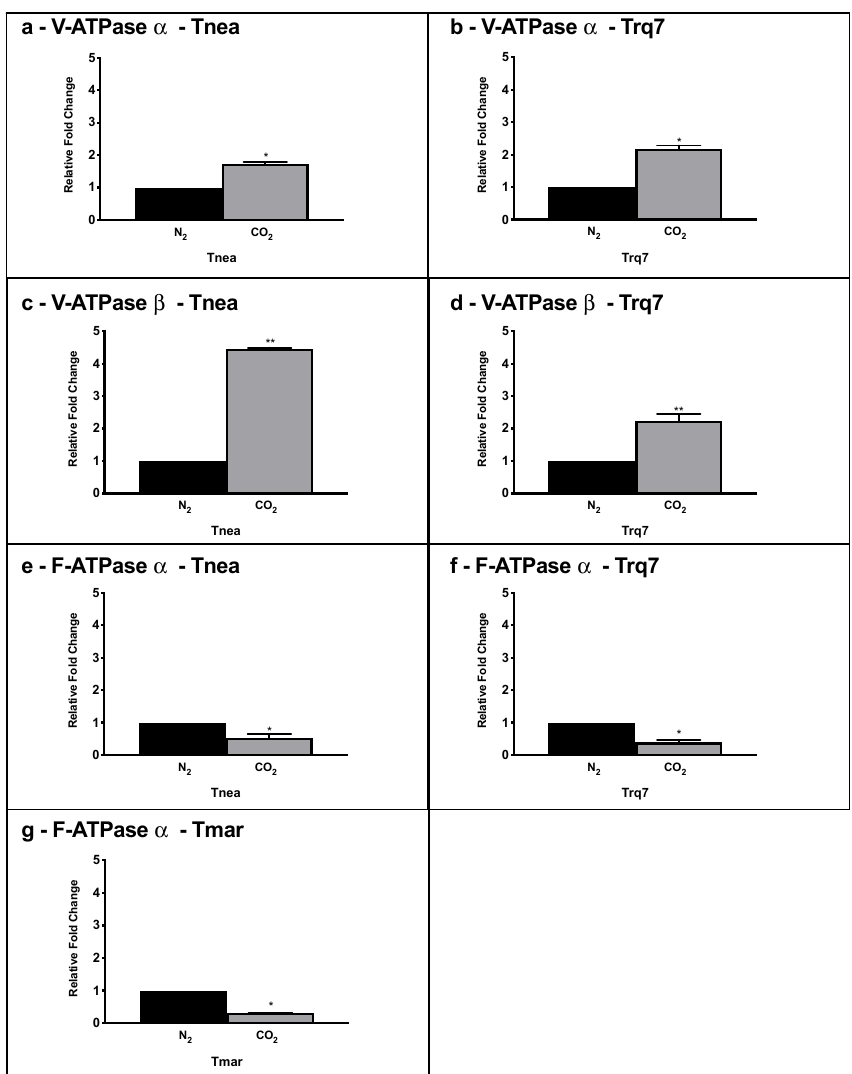
Figure 7. Gene expression levels of V-ATPase subunit α ( a , b ) V-ATPase subunit β ( c , d ), and F-ATPase subunit α ( e – g ), in Tnea , Trq7 , and Tmar under N 2 (black bars) and CO 2 (gray bars) conditions, measured by qRT-PCR. Variations are indicated as relative fold changes in CO 2 with respect to N 2 . mRNA levels were calculated relatively to the expression of 16S RNA. Asterisks indicate significantly different values at p ≤ 0.05 (*) and p ≤ 0.001 (**).